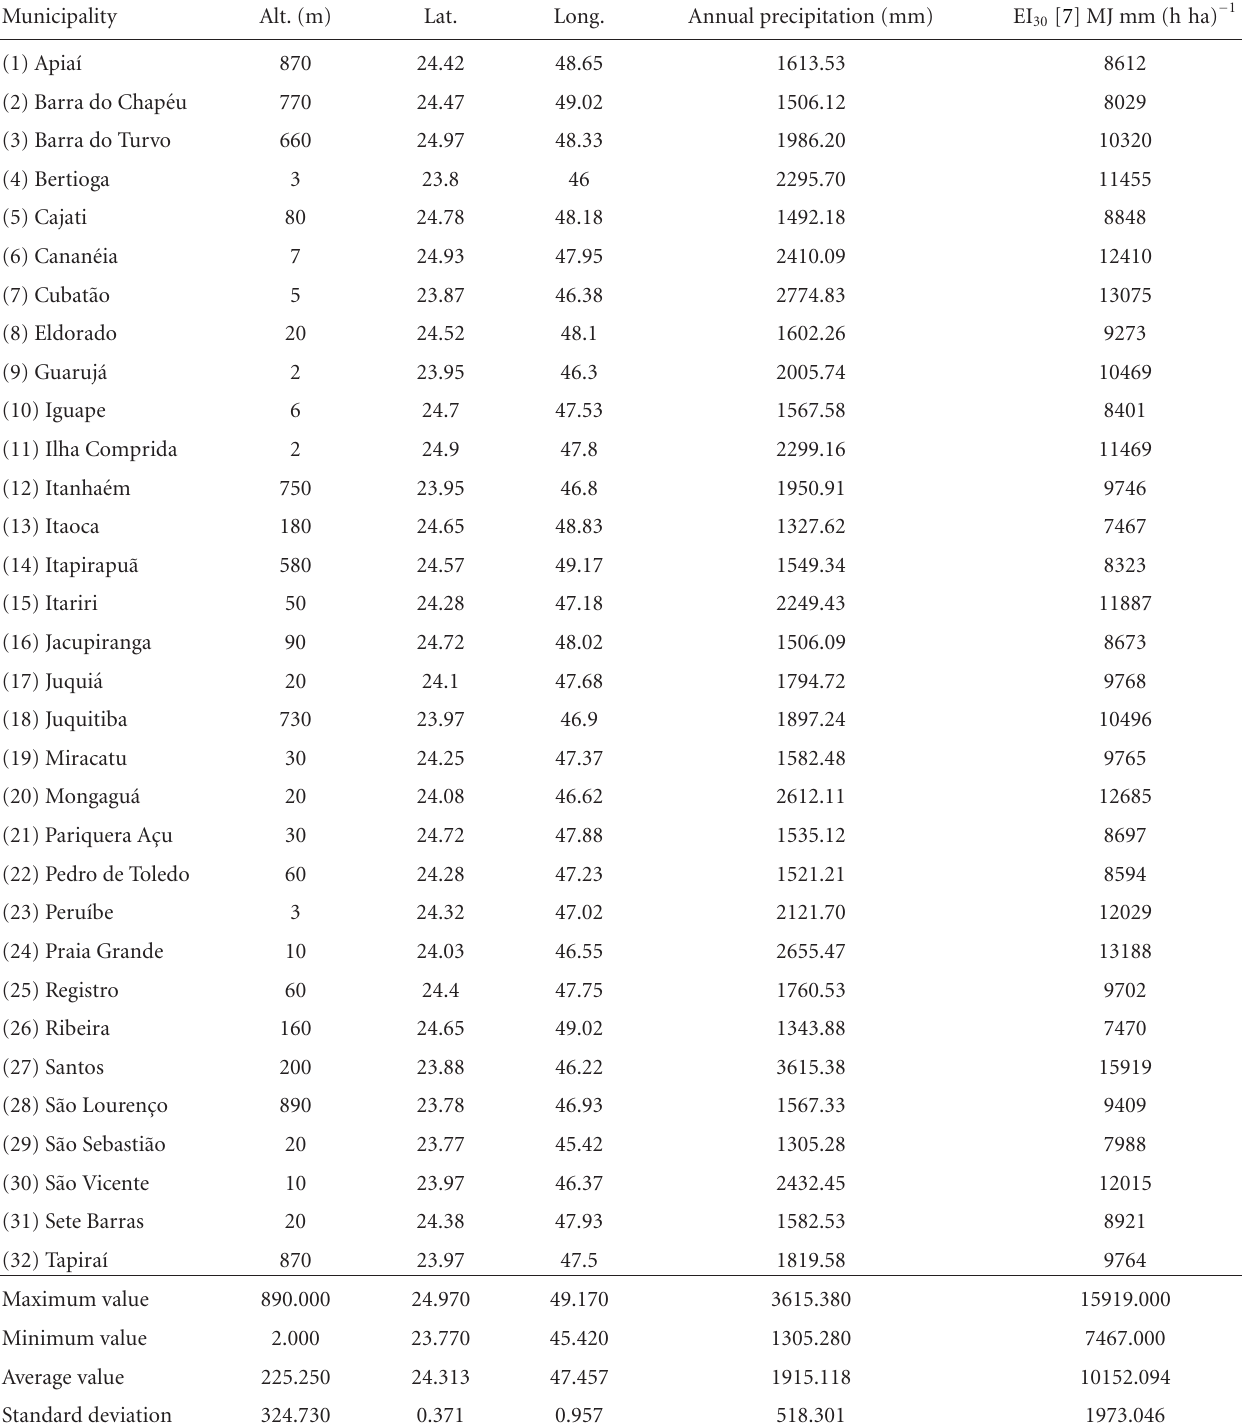
Table 1: Altitude, latitude, longitude, annual precipitation, and erosivity of 32 municipalities of the Ribeira Valley and Coastal region of the State of S˜ao